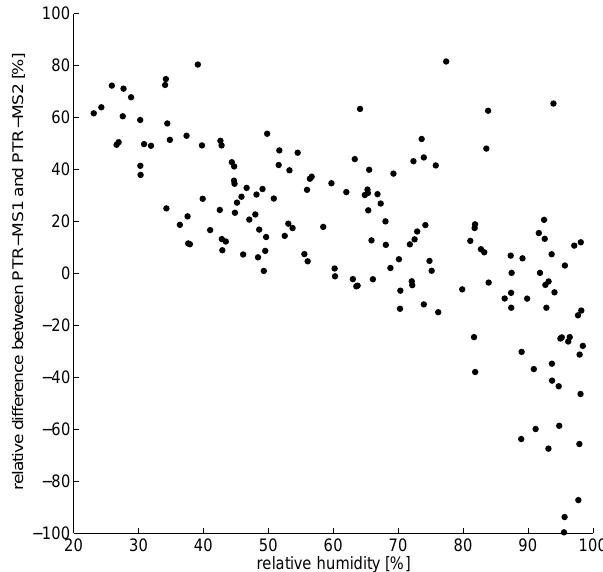
Figure 7. Relative difference of the acetaldehyde measurements with PTR-MS1 and PTR-MS2 against RH.